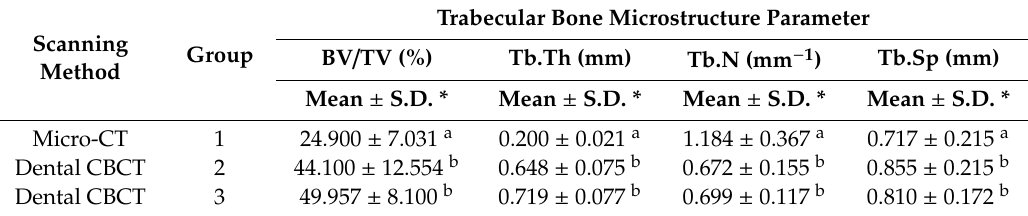
Table 2. Trabecular bone microarchitectural measurements of the three groups.